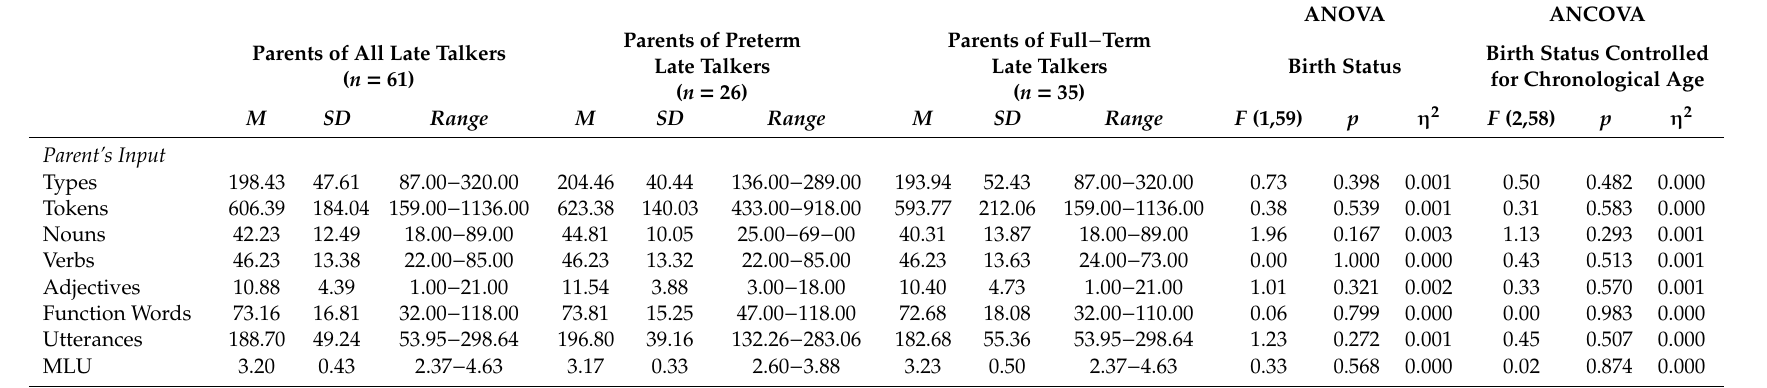
Table 3. Descriptive data for parent’s child − directed speech (input) variables. The table also summarizes the F , p and eta − squared values ( η 2 ) for the ANOVAs and ANCOVAs performed on the parent’s child directed speech (input) measures of the low-risk preterm and full-term late